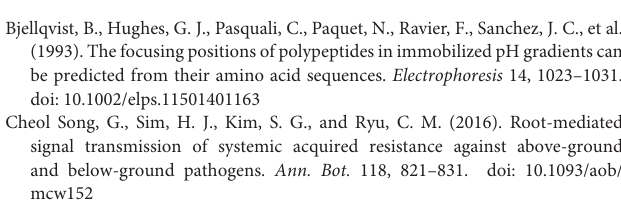
FIGURE S1 | Amino acid sequences alignment of pumpkin CmSGT1 with others. The three conserved domains (TPR, CS, and SGS) are shown by thin underlines. The genes included are CmSGT1 ( Cucumis melo L., XP_008439299.1) and CsSGT1 ( Cucumis sativus L., XP_004140745.1) AtSGT1A ( Arabidopsis , AT4G23570.3) and AtSGT1B ( Arabidopsis , AT4G11260.1), NbSGT1.1 ( N. benthamiana , AF516180) and NbSGT1.2 ( N. benthamiana ,